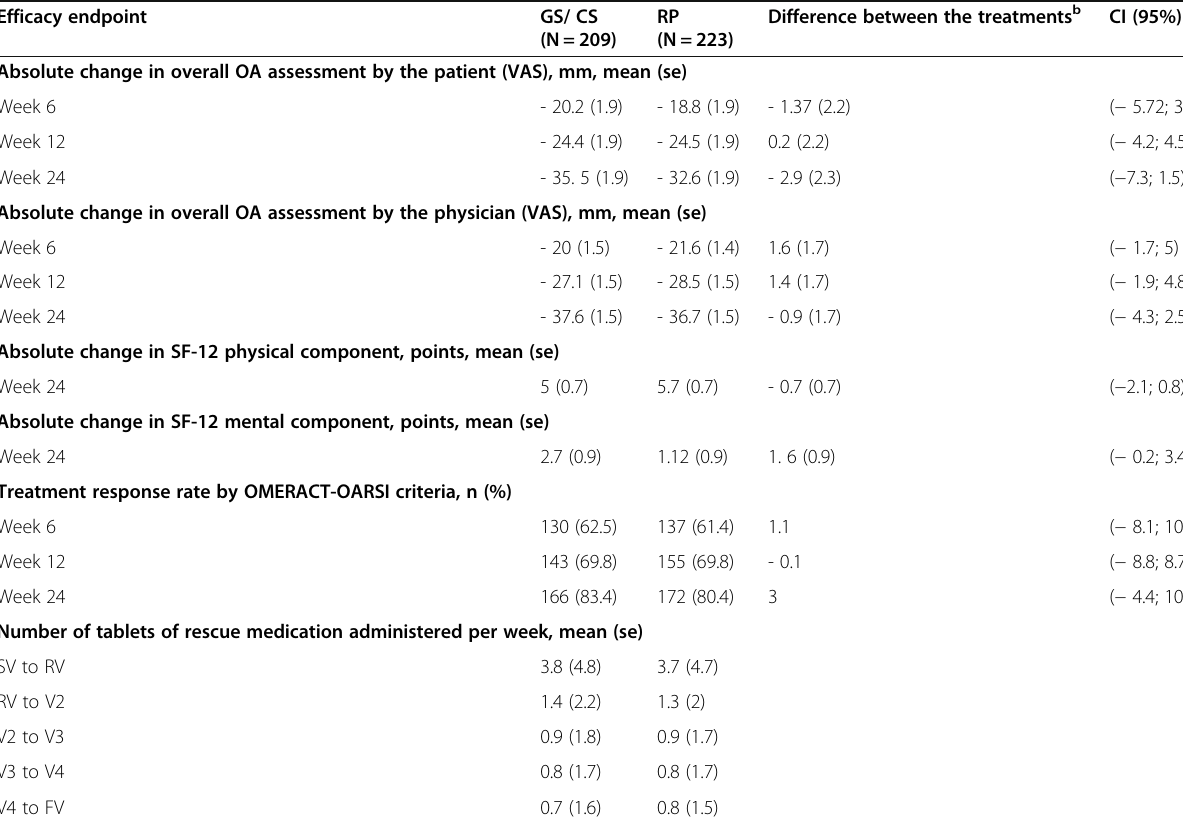
RP Difference between the treatments b (N = 209) (N = 223)